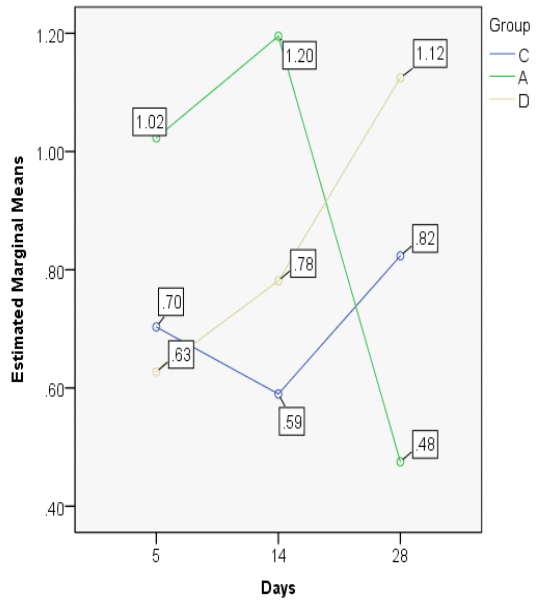
Figure 10. Epithelial thickness index (ETI) value distribution (boxplot representation).